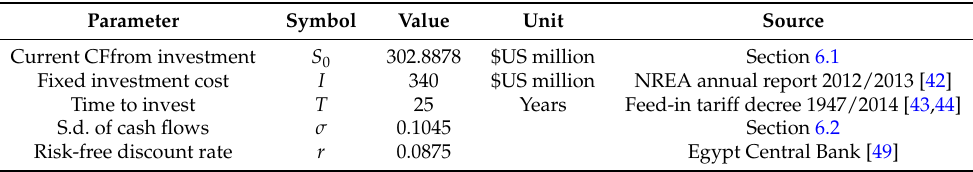
Table 2. Parameters used in the investment option case. NREA, New and Renewable Energy